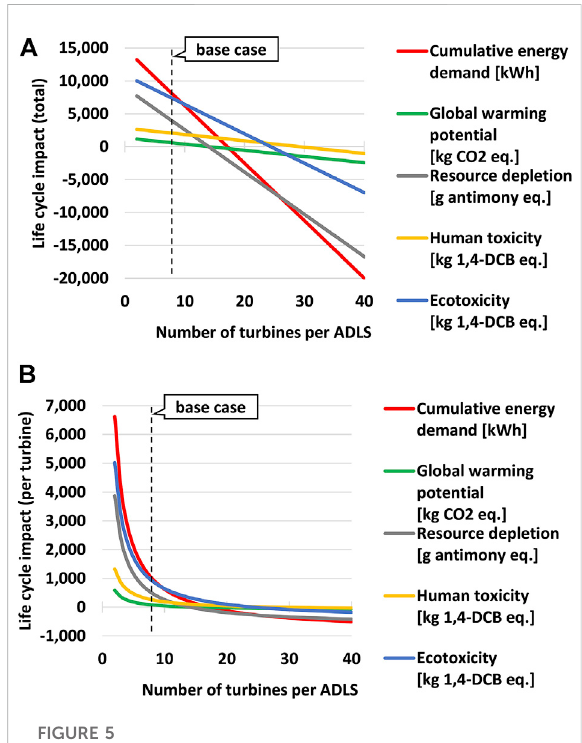
FIGURE 5 Life cycle impact of one ADLS for different numbers of covered WTs. Functional unit: one ADLS in the base case with varying numbers of WT. (A) per ADLS; (B) per